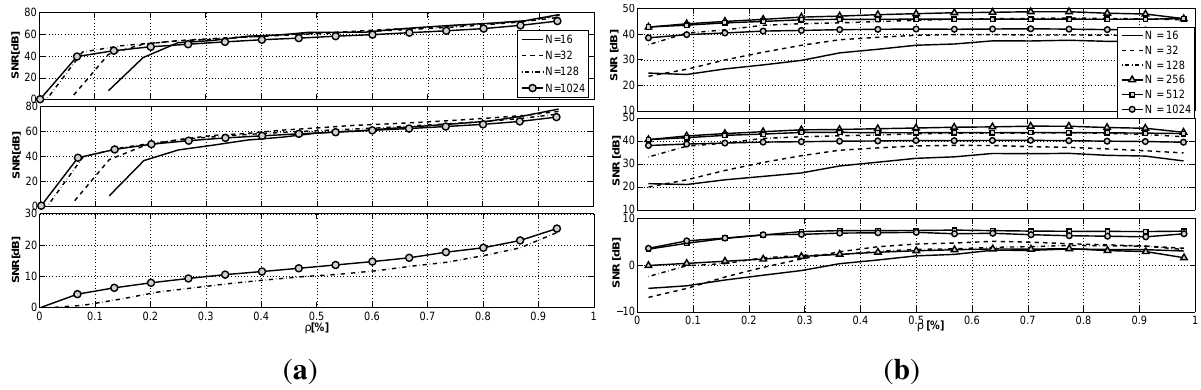
Figure 6. Reconstruction quality varying the sub-sampling factor ρ and using the signal length N as the parameter: ( a ) group sparse (GS)-CS and ( b ) LV-MAP. From top to bottom: temperature, humidity, light.